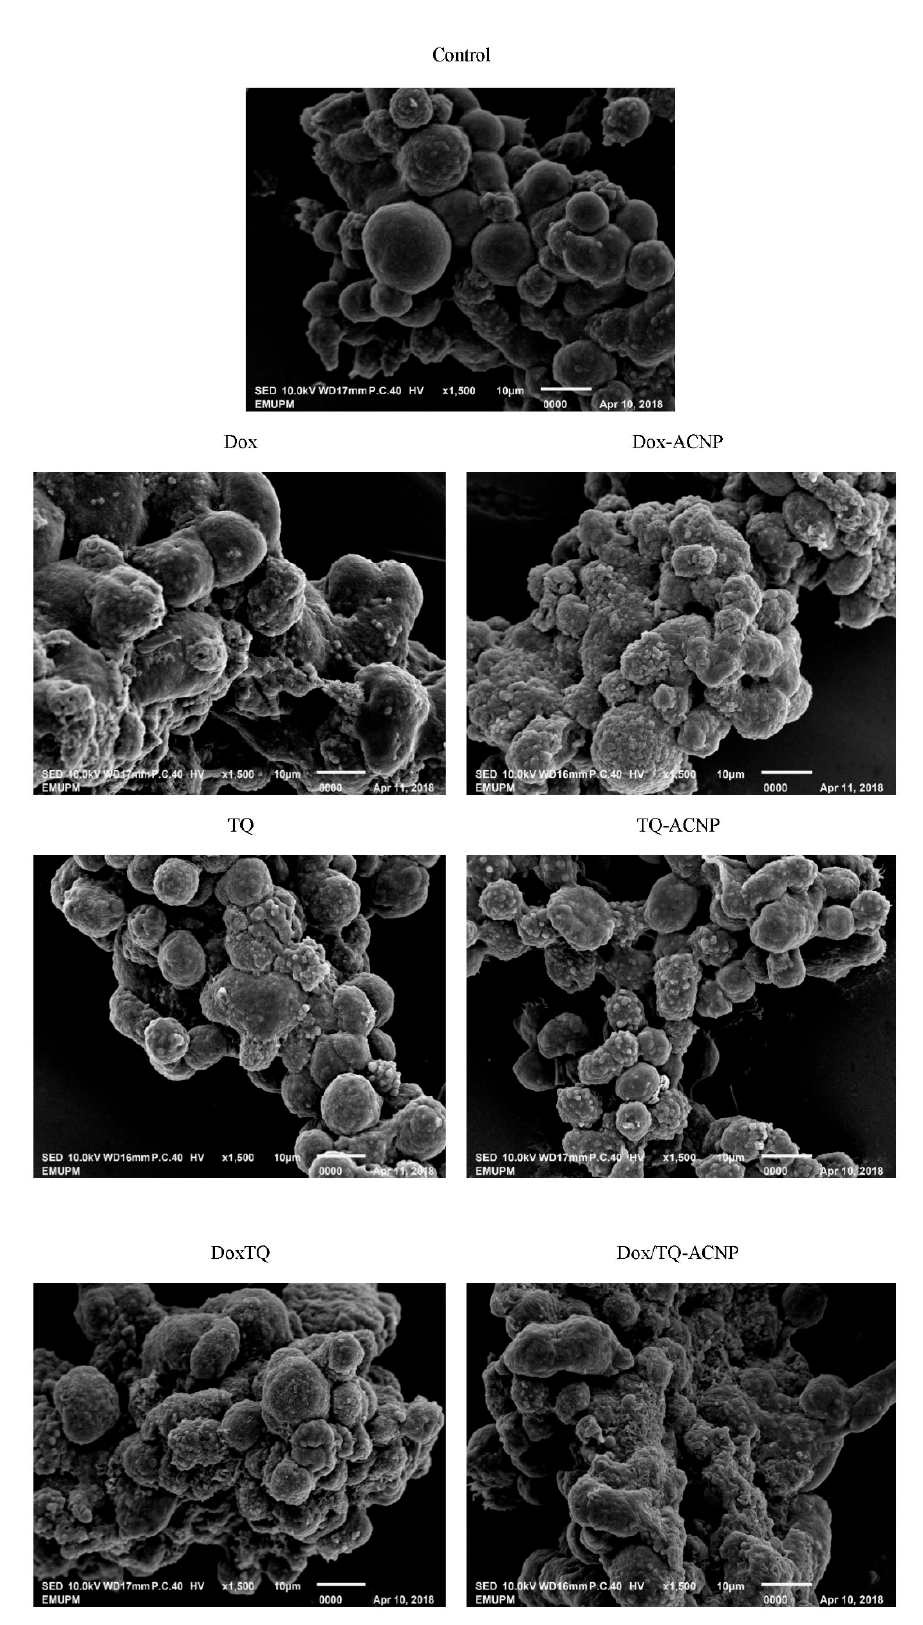
Figure 10. Scanning electron micrograph of 3D MDA MB 231 cells mammosphere after 10 days of treatment.